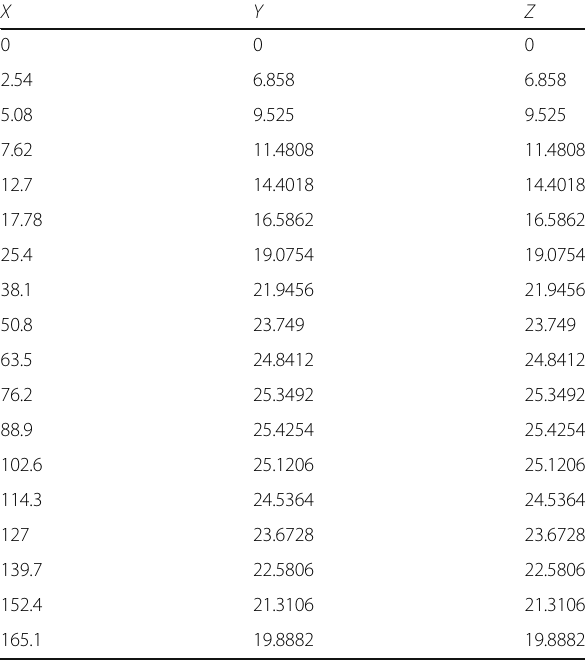
Table 2 Point-to-point characteristics of the cross-section A-A